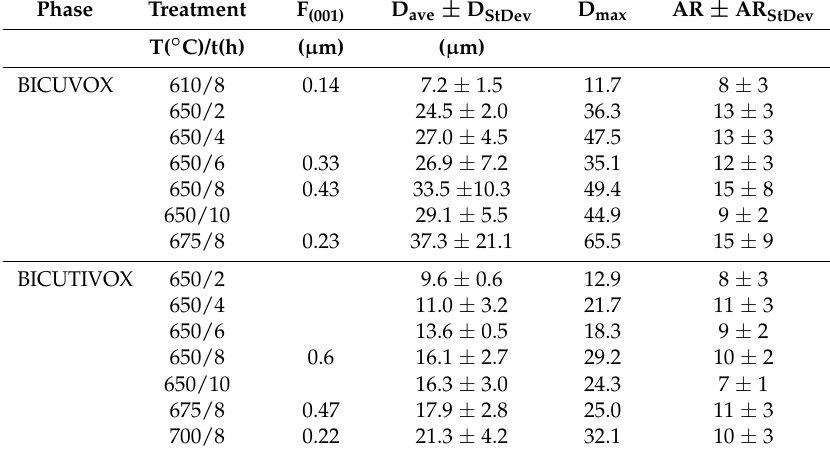
Table 1. Dimensional statistics and orientation factor, F , of salt-synthesized BIMEVOX platelets.